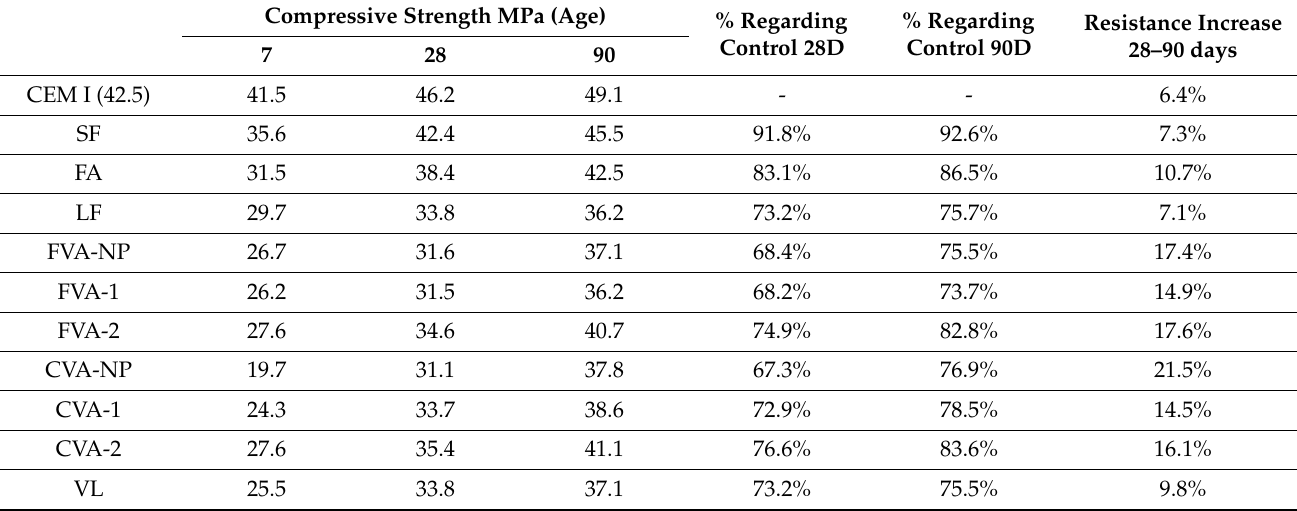
Table 7. Results of compressive strength in resistant activity index.